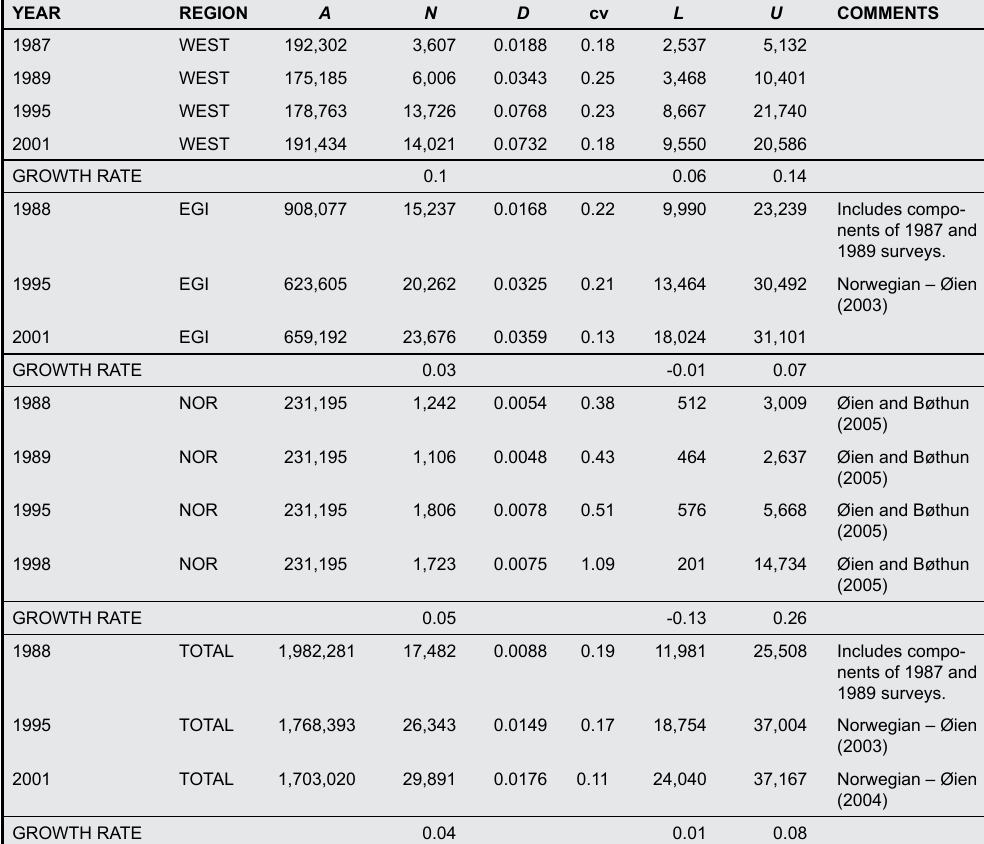
Table 5. Estimates of abundance by region for NASS shipboard surveys after post stratification. A – surface area (nm 2 ); N – abundance; D – density (no./nm2); cv – coefficient of variation for N and D ; L, U – lower and upper 95% confidence intervals for N . Regions are shown in Fig.